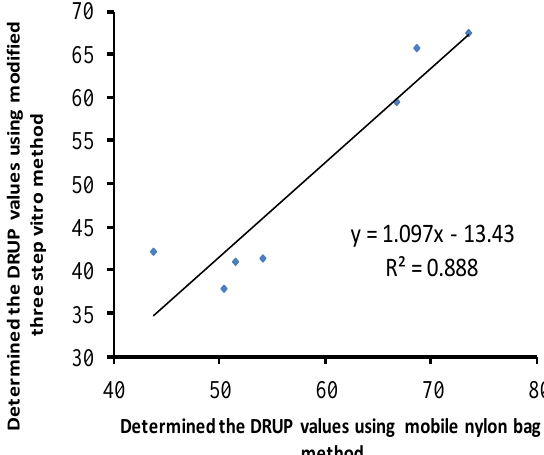
Figure 2. Predicted analysis between MNB observed values MTS observed value in the roughages. MNB, mobile nylon bag method; MTS, modified three-step in vitro method.